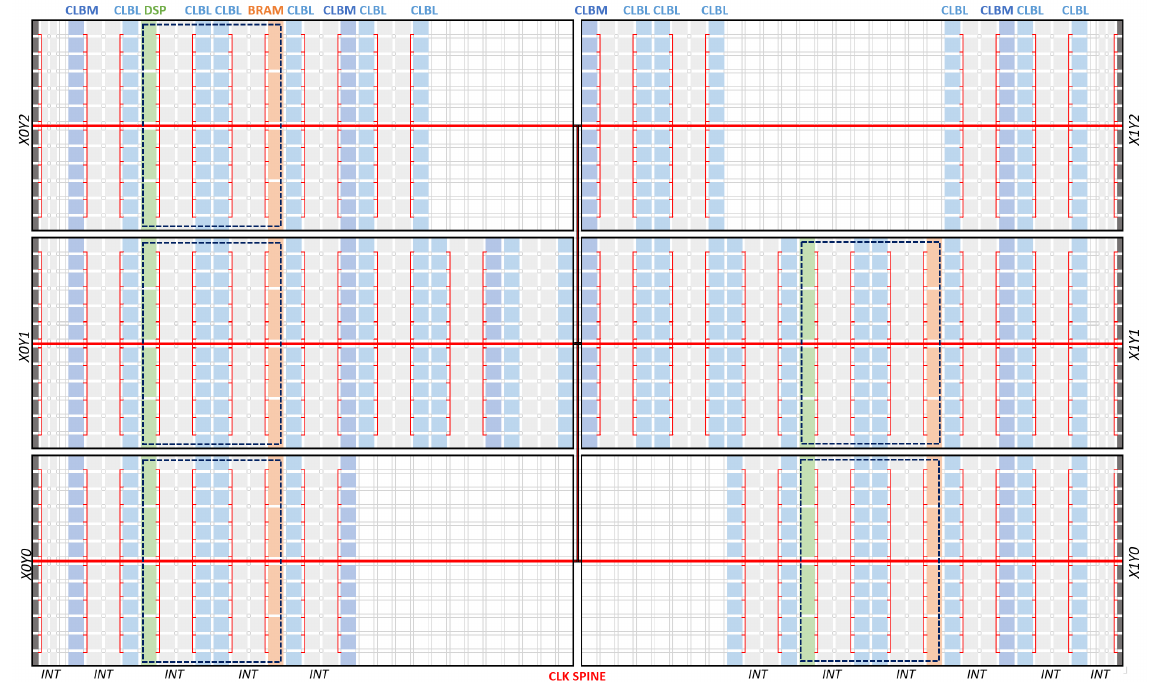
Figure 1. Simplified schematic of resource distribution in Xilinx 7-Series devices. The FPGA fabric is divided into lock regions (X0Y0 to X1Y2), interconnection blocks are located to either side of logic resources (CLB, BRAM, DSP). Dashed lines indicate repetitions of arbitrarily selected column pattern across clock